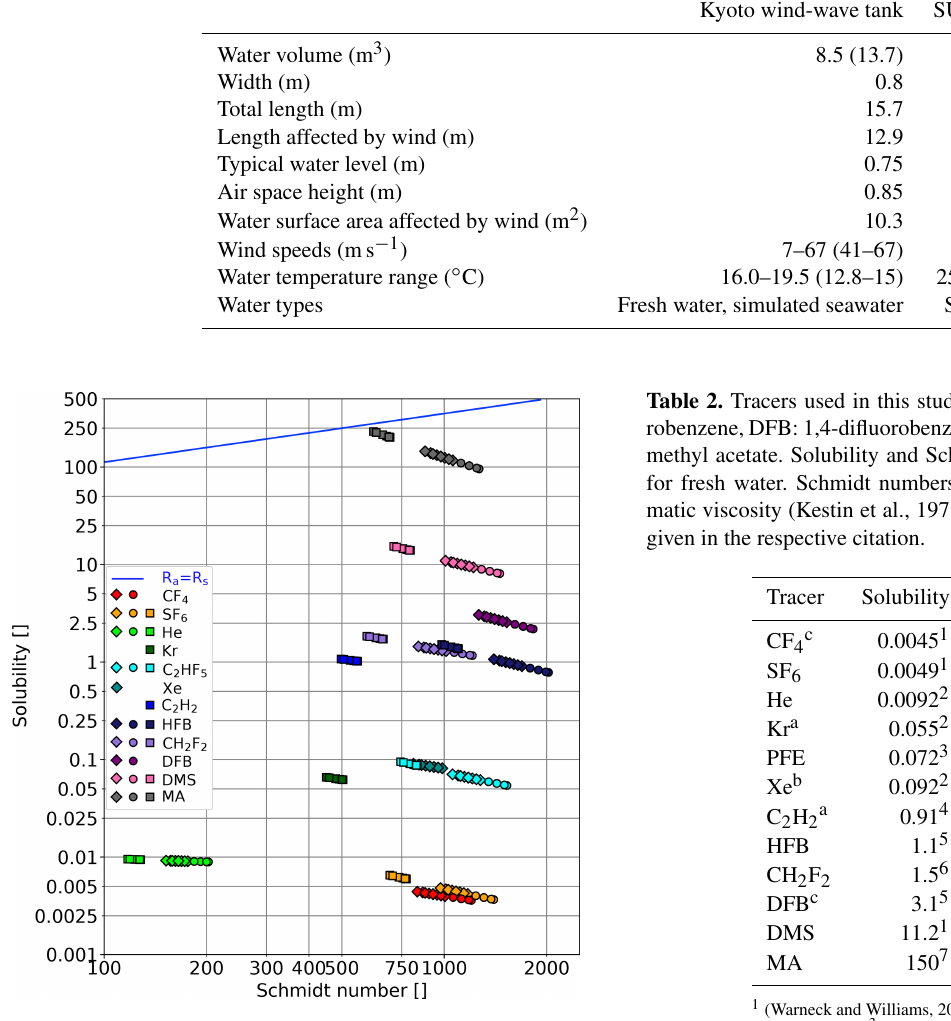
Figure 3. The solubility–Schmidt number combinations, for which the air-side resistance is equal to the water-side resistance, are shown as a blue line (Eq. 5 for a rough water surface). Diamonds: fresh water (Kyoto), circles: seawater model (Kyoto), squares: sea- water (Miami). The variations in the Schmidt number and solubility result from the varying water temperatures used in the different ex- periments; see Table 1.